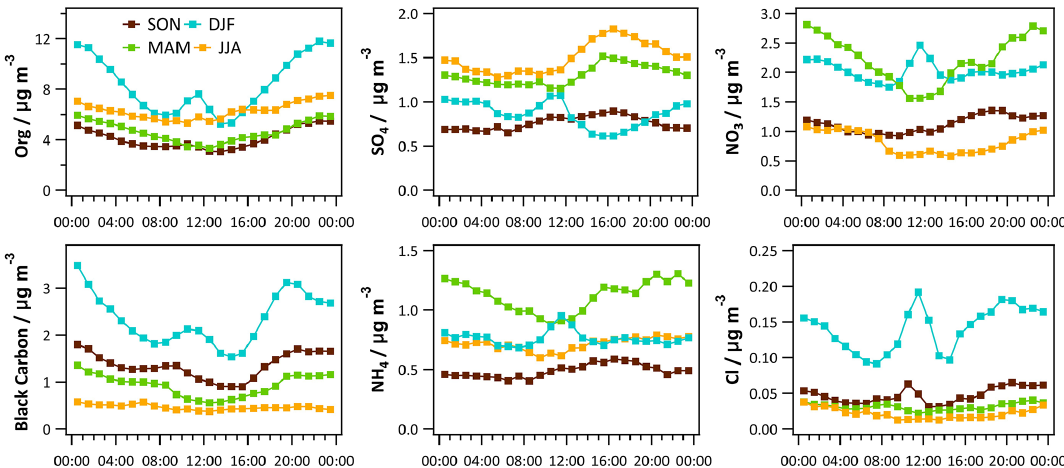
Figure 2. Seasonal, diurnal cycles of the measured PM 1 components (hourly averages) for the organic and inorganic species (sulfate, nitrate, ammonium, and chloride) of the ACSM and equivalent black